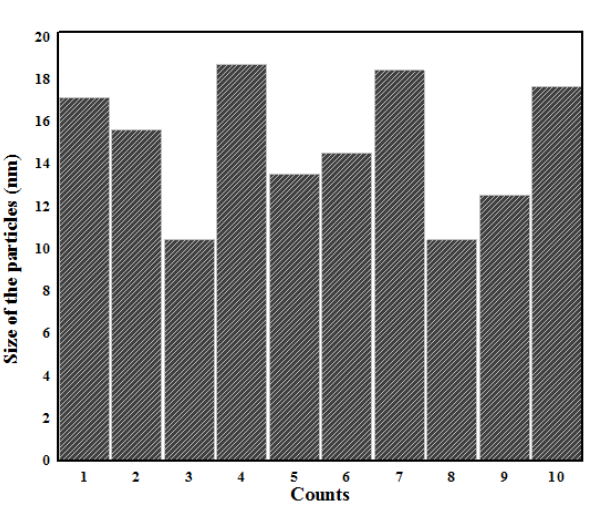
Figure 7: Particle size distribution of ZnO